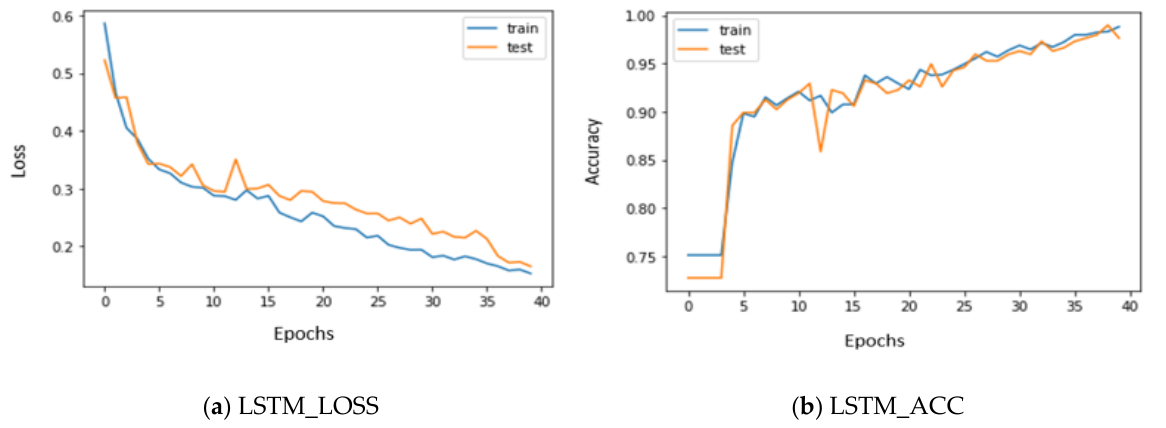
Figure 6. The loss and the accuracy curve of LSTM_model.